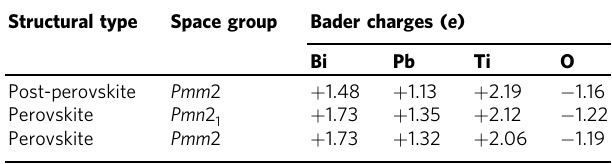
Table 1 Bader charges for bulk